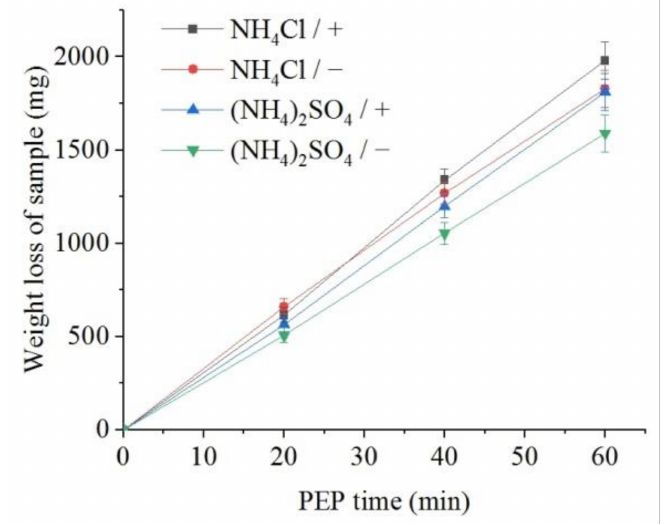
Figure 6. Dependence of the weight loss of the nitrided samples on the PEP duration at 300 V in ammonium sulfate (3%) or ammonium chloride (3%) solutions at their temperature of 80 ◦ C under forced circulation (+) or natural convection ( − ) of electrolyte.